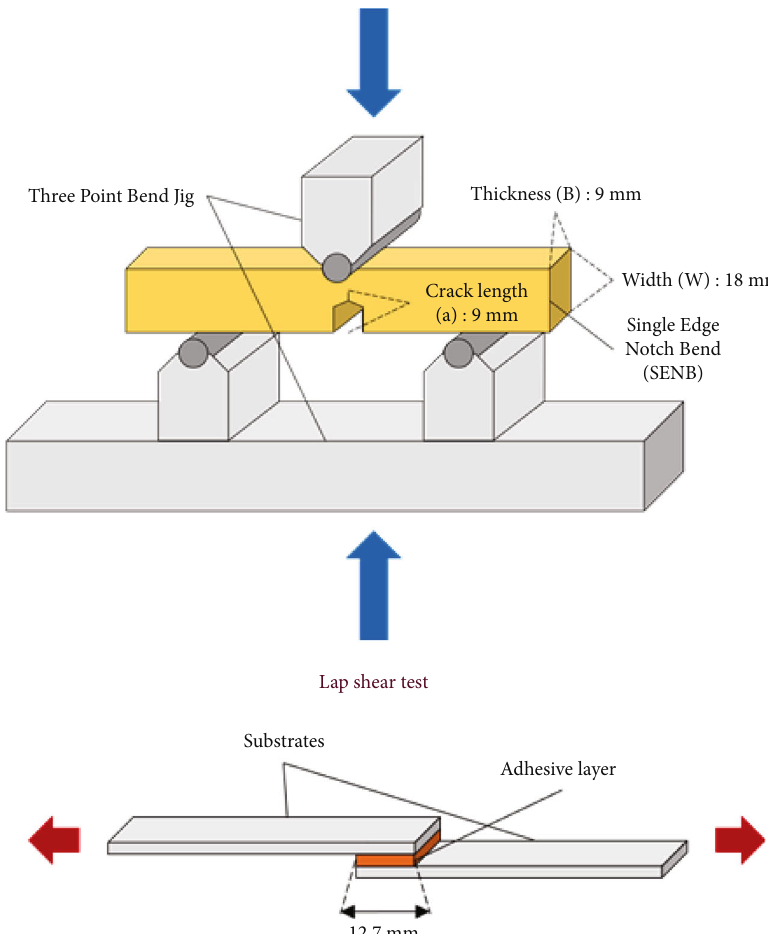
Figure 1: Specimen setup for lap shear test and fracture